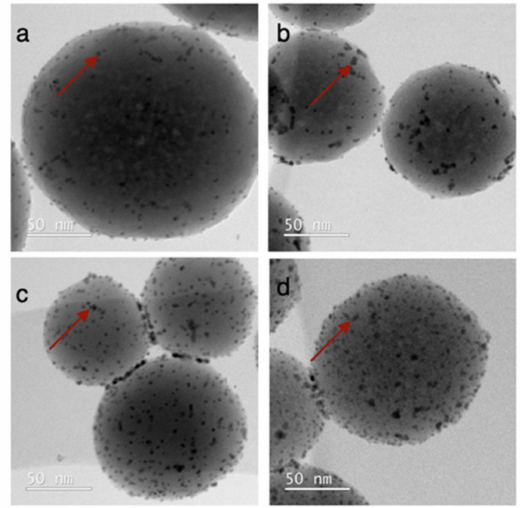
Figure 2. TEM analyses of Ru nanoparticle catalysts on SiO 2 , prepared by impregnation with Ru 3 (CO) 12 and subsequent thermal decomposition, and with a Ru loading of ( a ) 0.96% w / w , ( b ) 2.15% w / w , ( c ) 3.49% w / w and ( d ) 4.84% w / w . The red arrows illustratively point out a supported Ru